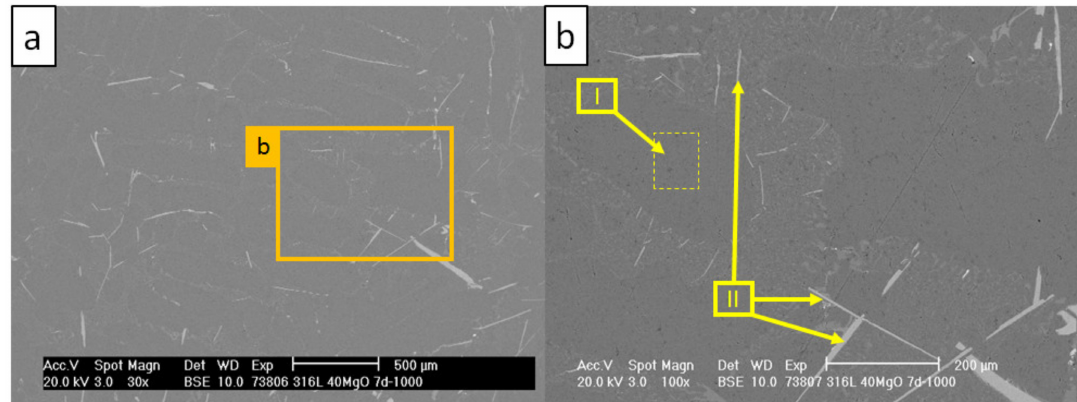
Figure 20. SEM micrographs revealing the AlSi7Mg0.3 microstructure at 1 mm distance from the C_1000 interface: ( a ) image magnified to 30 × ; ( b ) image magnified to 100 × . Table 16. Results of EDS scans corresponding with areas indicated by arrows in Figure 20 (in at %). Scan Mg